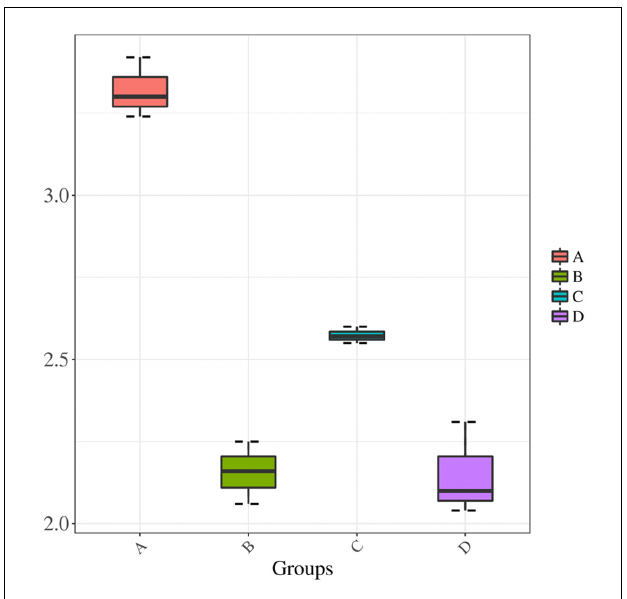
FIGURE 3 | Shannon diversity estimates. Horizontal axis indicates the four treatments A, B, C, and D; vertical axis represents the Shannon diversity values.